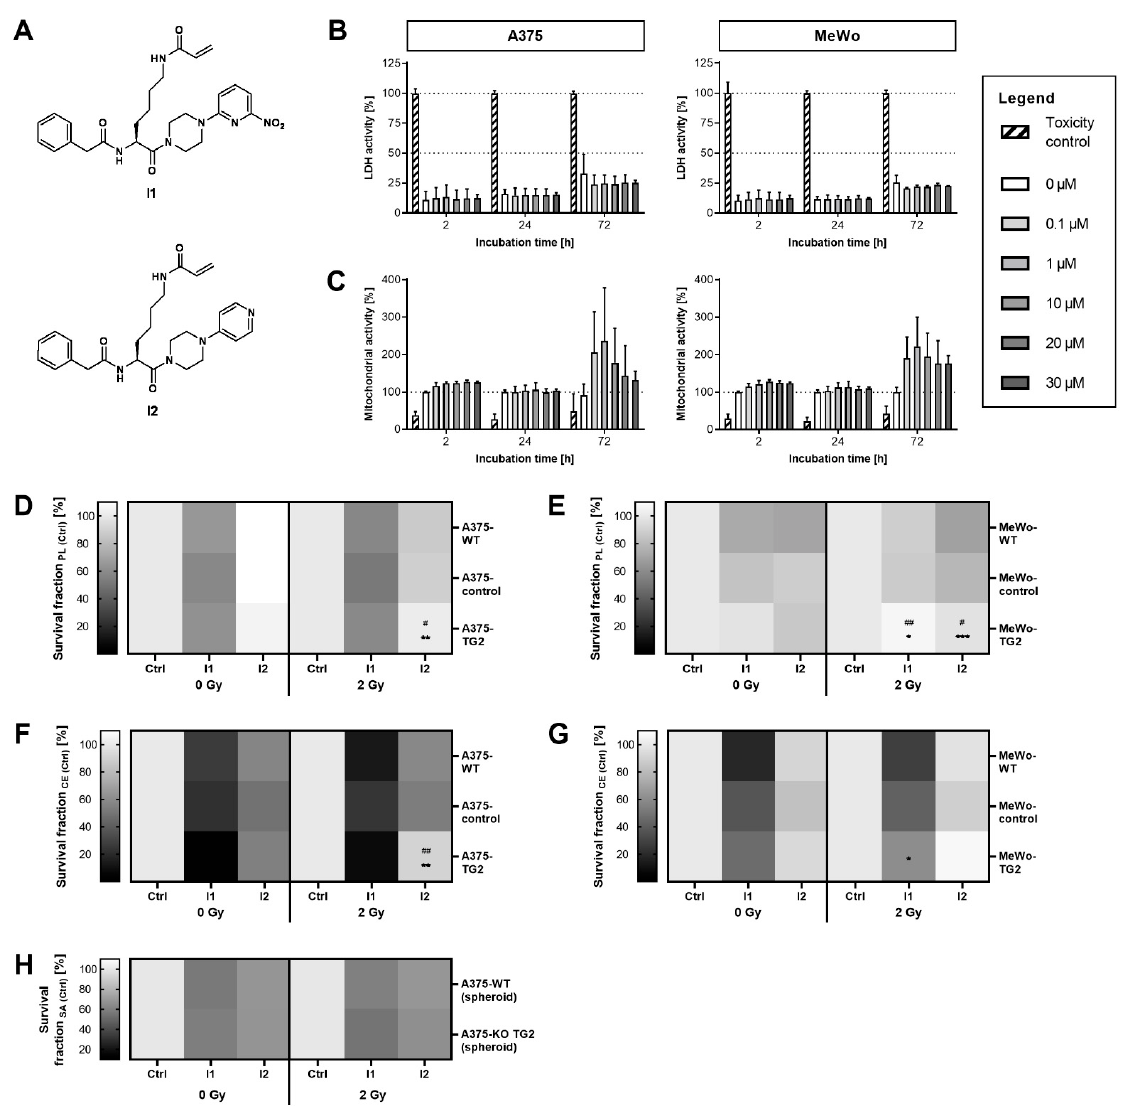
Figure 4. Influence of irreversible TG2 inhibitors on the proliferation and clonal expansion of melanoma sub-cell lines after irradiation. ( A ) Structure of irreversible TG2 inhibitors N α -Phenylacetyl- N ε -acryloyl- L -lysine-4-(6-nitropyridin-2-yl) piperazide ( I1 ) and N α -Phenylacetyl- N ε -acryloyl- L -lysine-4-(pyridin-4-yl) piperazide ( I2 ), which exhibit comparable inhibitory potentials but differ in their membrane permeation rates ( I1 >> I2 ) [43]. ( B , C ) Toxicity of TG2 inhibitor I1 on A375- (left) and MeWo-WT (right) cells. Cytotoxicity ( B ) was determined by lactate dehydrogenase (LDH) activity (normalized to toxicity control values) and cell viability ( C ) by mitochondrial activity (nor- malized to inhibitor-free sample values (0 µM)). ( D , E ) Proliferation (PL) after irradiation of A375 ( D ) and MeWo ( E ) sub-cell lines in presence of TG2 inhibitors. Survival fractions were normalized to inhibitor-free irradiation-equal controls of each cell line (control). ( F , G ) Clonal expansion (CE) after irradiation of A375 ( F ) and MeWo ( G ) sub-cell lines in presence of TG2 inhibitors. Survival fractions were normalized to inhibitor-free irradiation-equal controls of each cell line (control). ( H ) Expansion of spheroidal area of A375-WT and -KO TG2 cells at day 14 after irradiation and treatment with TG2 inhibitors. Spheroidal areas were normalized to inhibitor-free irradiation-equal controls of each cell line (control). Mean values ± SD or mean values alone (when heatmaps were used) from individual experiments ( n ≥ 4) are shown. Significant variances of treatment-equal sam- ples are displayed as * (TG2 vs. WT, p ≤ 0.05), ** (TG2 vs. WT, p ≤ 0.01), *** (TG2 vs. WT, p ≤ 0.001), # (TG2 vs. control, p ≤ 0.05), and ## (TG2 vs. control, p ≤